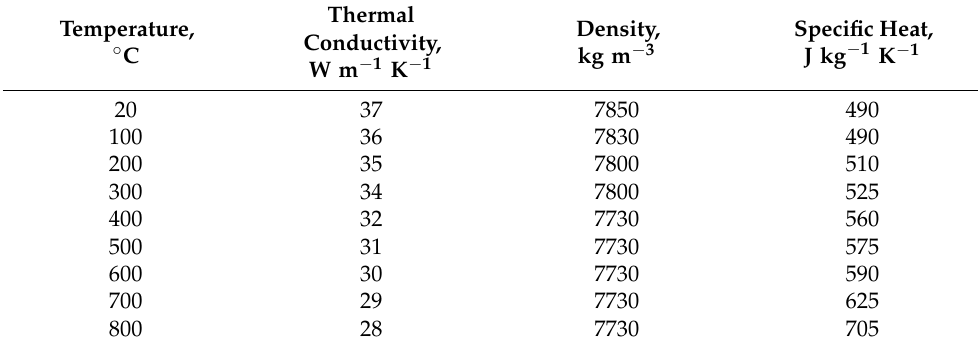
Table 2. Temperature-dependent properties of the steel 65H